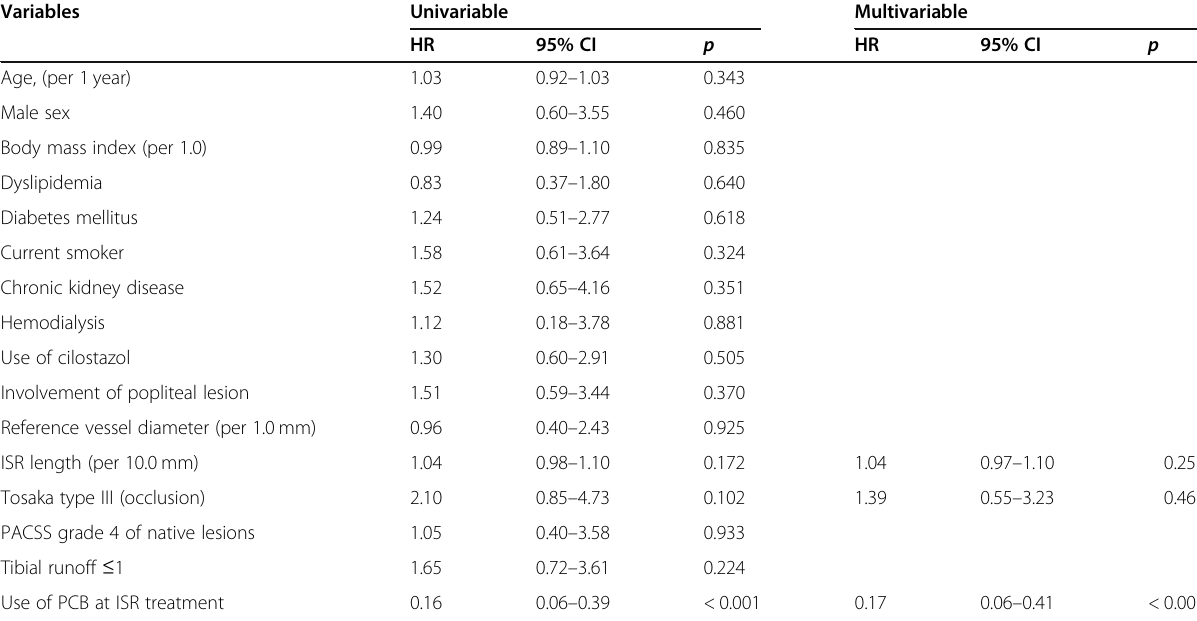
Table 5 Predictors of Recurrent Restenosis within 5 Years after Treatment of In-stent Restenosis in the Matched Population